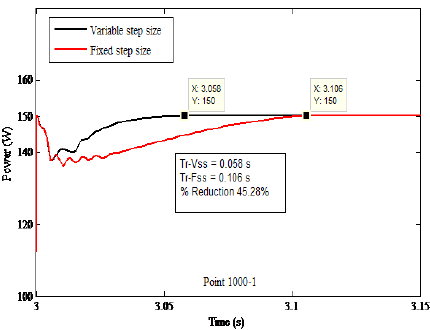
Fig. 12: Output power: Zoom in Point 750-2.